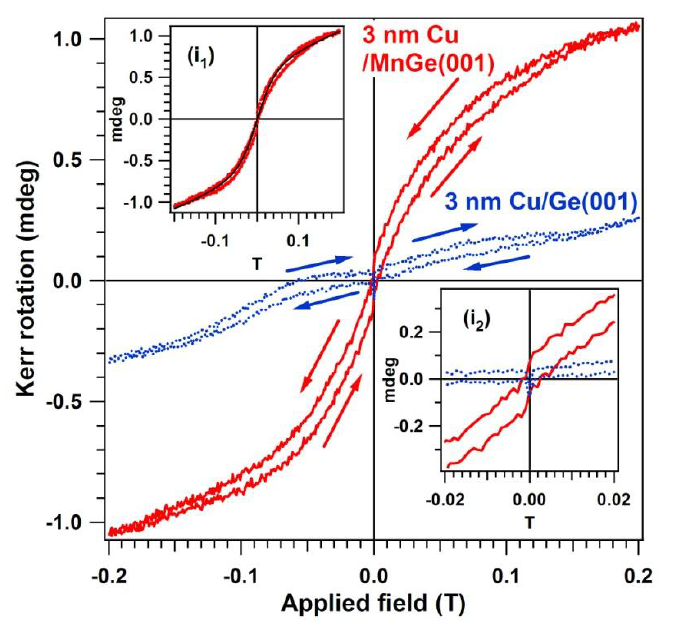
Figure 7. Magneto-optical Kerr effect (MOKE) hysteresis loops obtained on the sample with the equivalent of 100 nm Mn embedded in Ge(001), in red (full) curve, together with a measurement on a clean Ge(001) capped with the same amount of Cu as the Mn-Ge sample, in blue (dashed). Arrows represent the sense of evolution of the hysteresis (counter-clockwise for MnGe, clockwise for Ge). Insert (i combinantion of Brillouin functions for assessing the superparamagnetic component. Insert (i ) represents a detail of the hysteresis loops in the low field 2